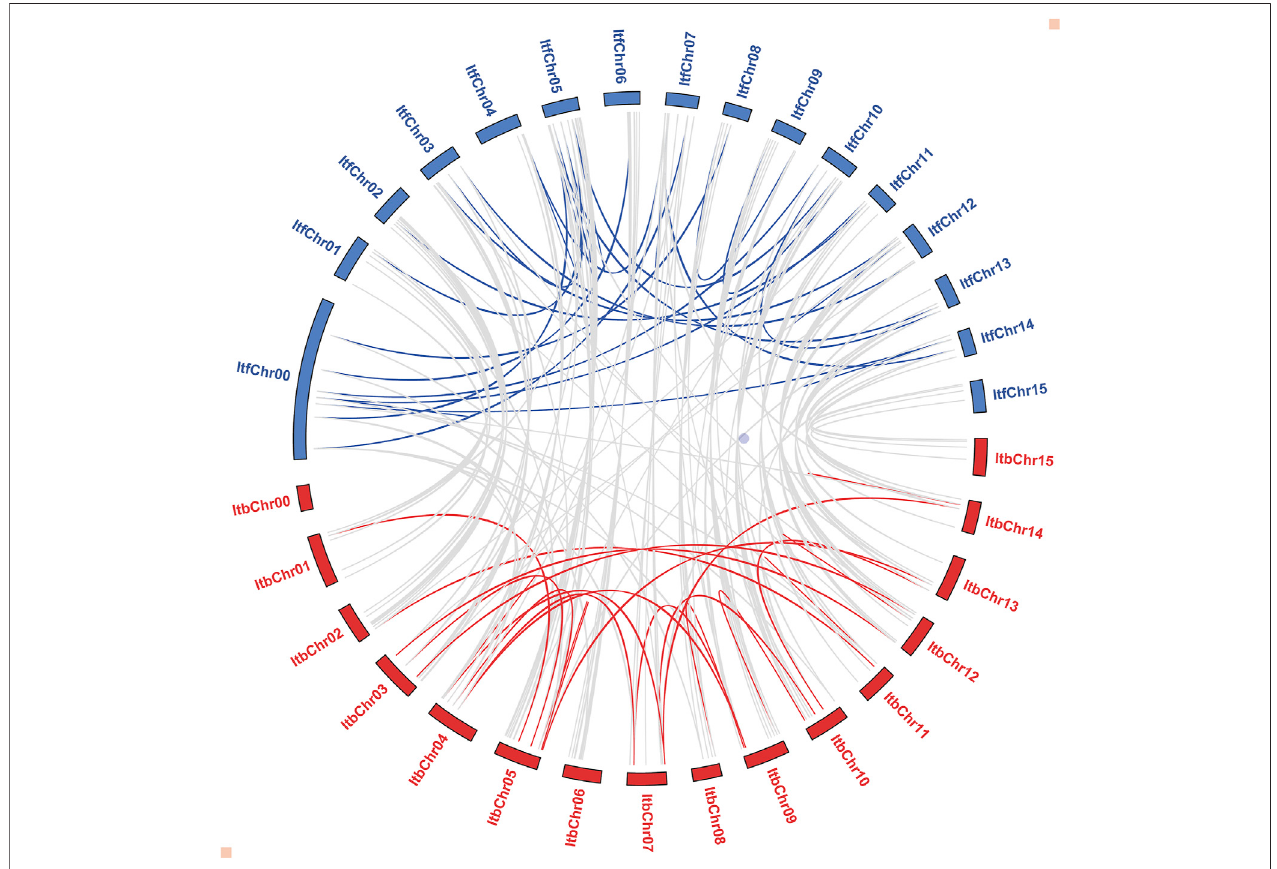
FIGURE 4 | Syntenic relationship among ItbNAC and ItfNAC genes. Red and blue curves represent the synteny relationship of NAC genes in the Ipomoea triloba and Ipomoea tri fi da genomes, respectively. Grey curves represent the synteny relationship among ItbNAC and ItfNAC genes.